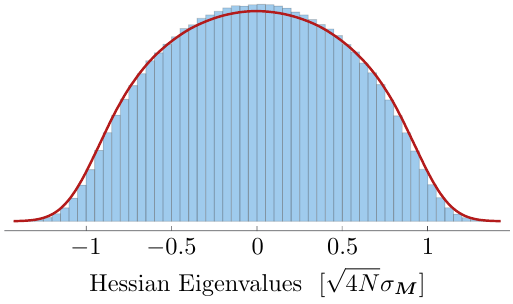
Figure 17 . Normalized eigenvalue spectrum of Hessian of potential along with random matrix model for N = 20, P =